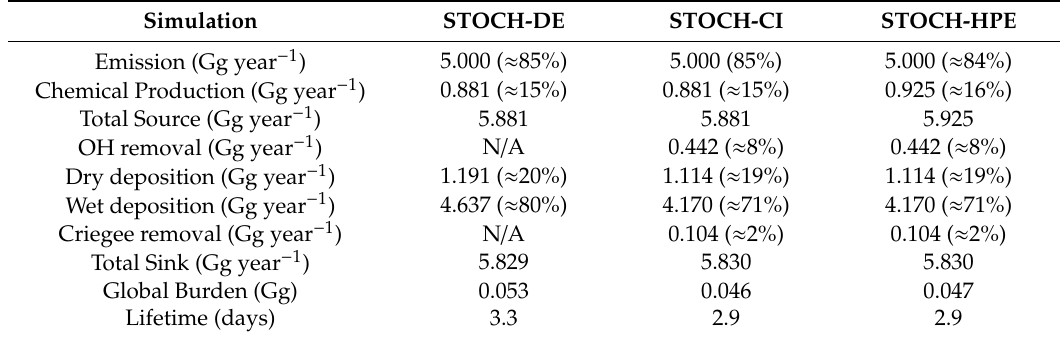
Table 2. Global flux data (with percentage contributions to total source / sink), global burden and lifetime of PFOA from successive simulations. The percentage contributions are shown in the parenthesis. Simulation